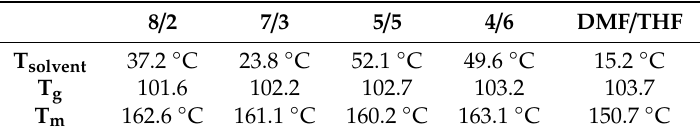
Figure 6. ( a ) Thermal properties of electrospun TPU nanofibers by DSC; ( b ) XRD patterns of TPU nanofibers. Table 2. Thermal properties of TPU